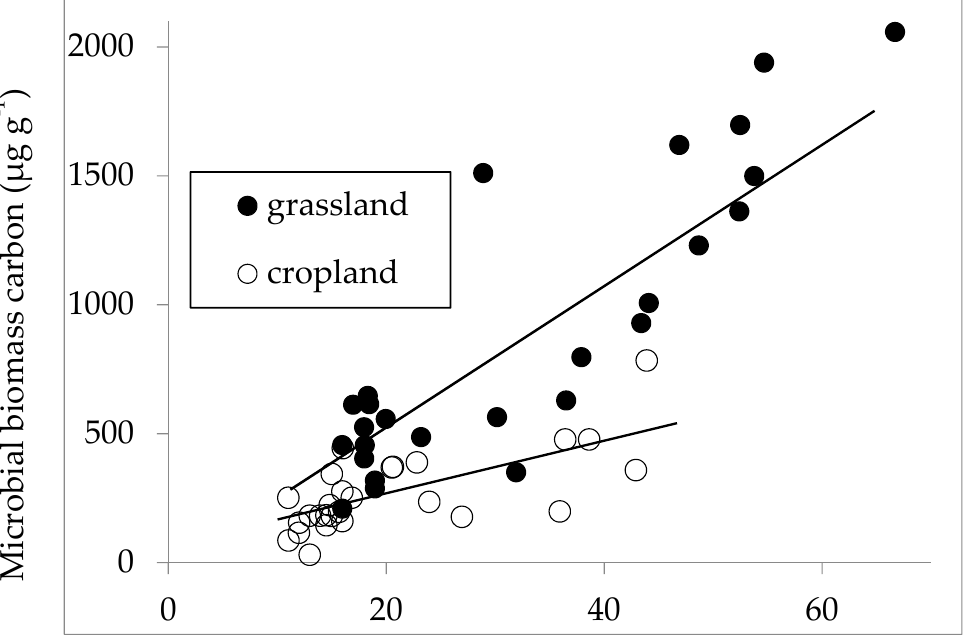
Figure 1. Microbial biomass carbon in relation to soil organic carbon for grassland and cropland. Respective linear regressions are: for grassland, y = 27.2 x − 31.7 with r 2 = 0.76 and n = 28; and for cropland, y = 10.7 x + 48.2 with r 2 = 0.48 and n = 27.